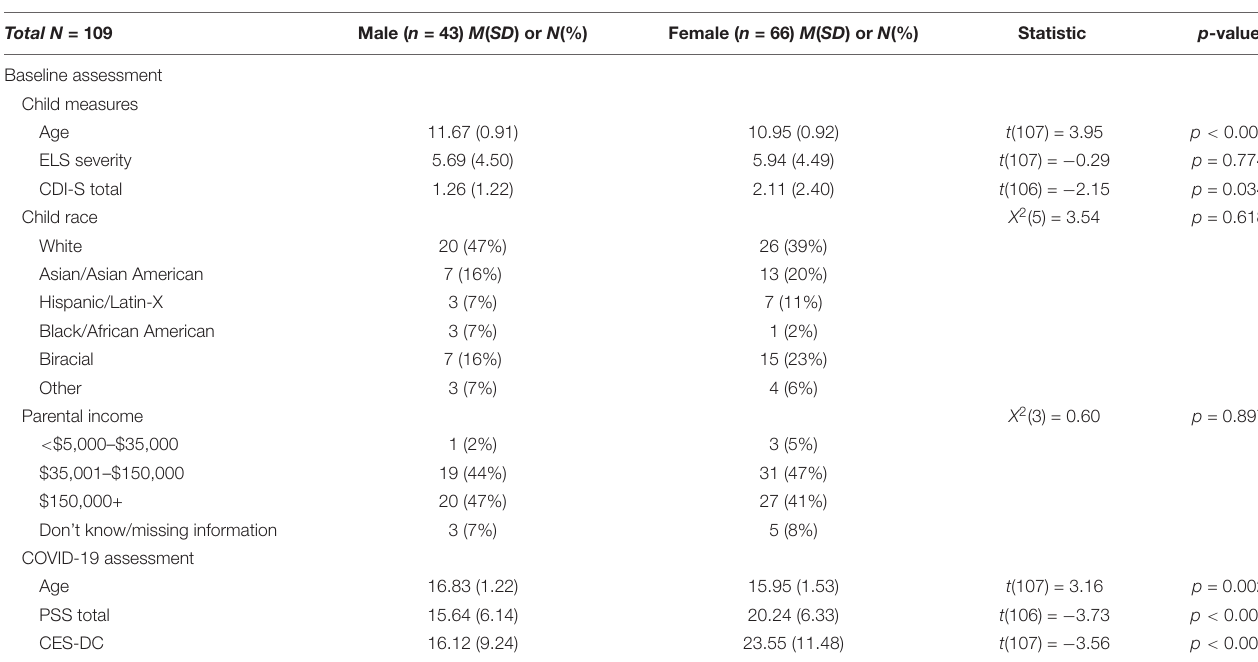
TABLE 1 | Descriptive statistics of study sample by